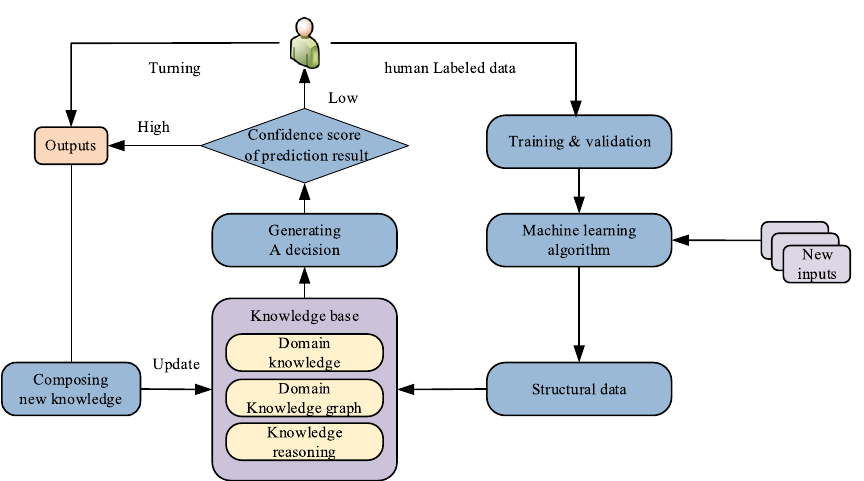
Fig. 5 Basic framework of hybrid